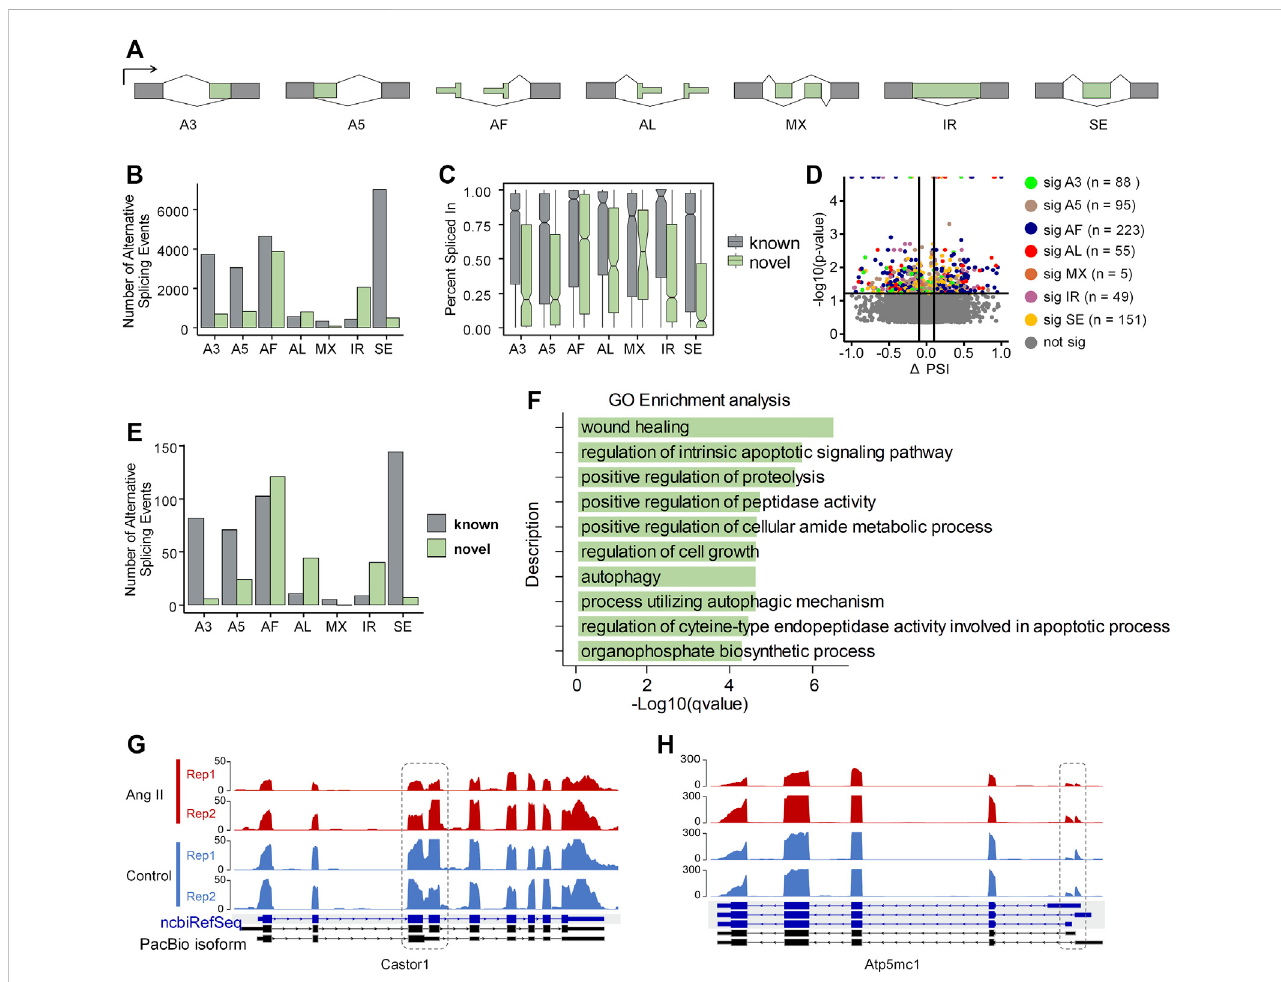
FIGURE 4 Overview of Alternative splicing (AS) events in Ang II-induced RAEC senescence. (A) Schematic diagram of the seven types of AS events de fi ned by SUPPA2whencomparedtoncbiRefSeqofratgenome. (B) ThenumberofASeventsdetectedbySUPPA2basedonIso-Seqtranscriptome. (C) Expressionratio of AS events in novel and known. (D) Differential AS events ( p -value < 0.05) between Ang II and control conditions. (E) The number of signi fi cantly spliced AS events between Ang II and control. (F) GO enrichment analysis of differentially spliced genes between Ang II and control cells. (G) RNA-seq track plot of gene Castor1 beforeandafterAngIIstimulation.Dashedcircleindicatesthedifferentialintronretention(IR)eventbetweentwoconditions. (H) RNA-seqtrack plot of gene Atp5mc1 upon Ang II treatment. The dashed circle represents the alternative fi rst exon (AF) event between two